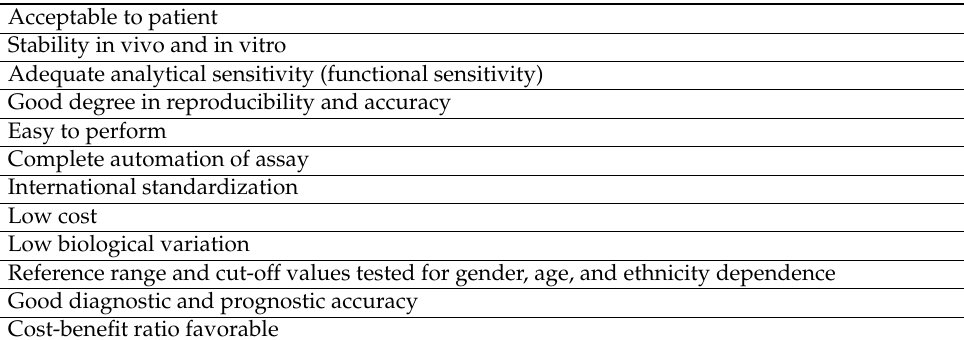
Table 2. Characteristics of an ideal biomarker (according to references